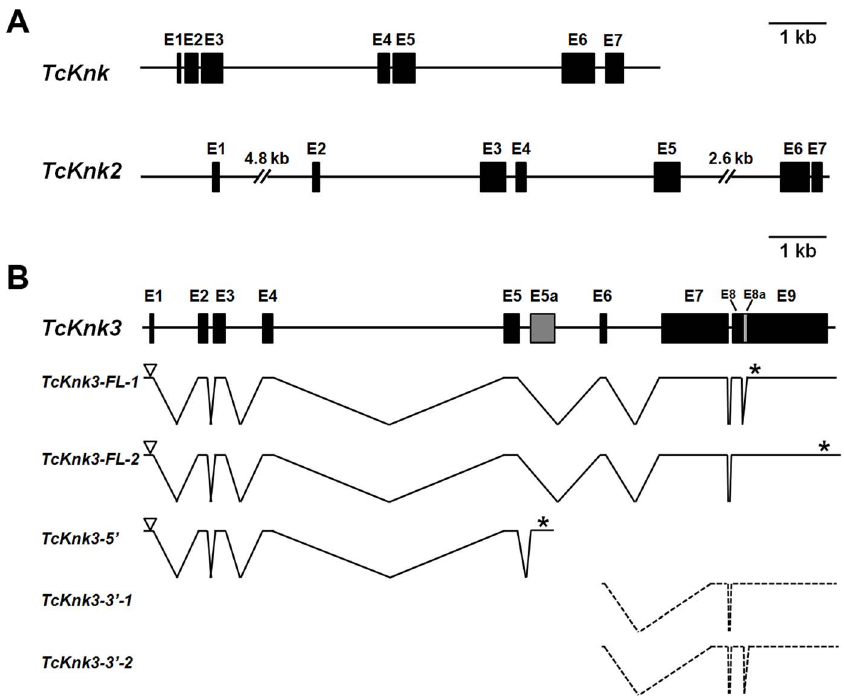
Figure 1. Schematic diagram of the exon–intron organizations of the putative TriboliumcastaneumKnk -family genes. (A–B) The exon– intron organization of each TcKnk -family- gene was determined by sequence comparison between genomic sequence and the longest available cDNA sequence. (A) Gene organization of TcKnk and TcKnk2 ; (B) Alternatively spliced forms of TcKnk3 ( TcKnk3-FL-1 , TcKnk3-FL-2 , TcKnk3-5 9 , TcKnk3-3 9 -1 and TcKnk3-3 9 -2 ). Black closed boxes indicate exons (E) and lines indicate the introns. The gray colored closed box indicates exon 5a for TcKnk3-5 9 . The open arrowheads represent the open reading frame start codons and * indicates the stop codons. The TcKnk3-3 9 -transcripts are indicated using broken lines because the precise location of the 5 9 -ends are